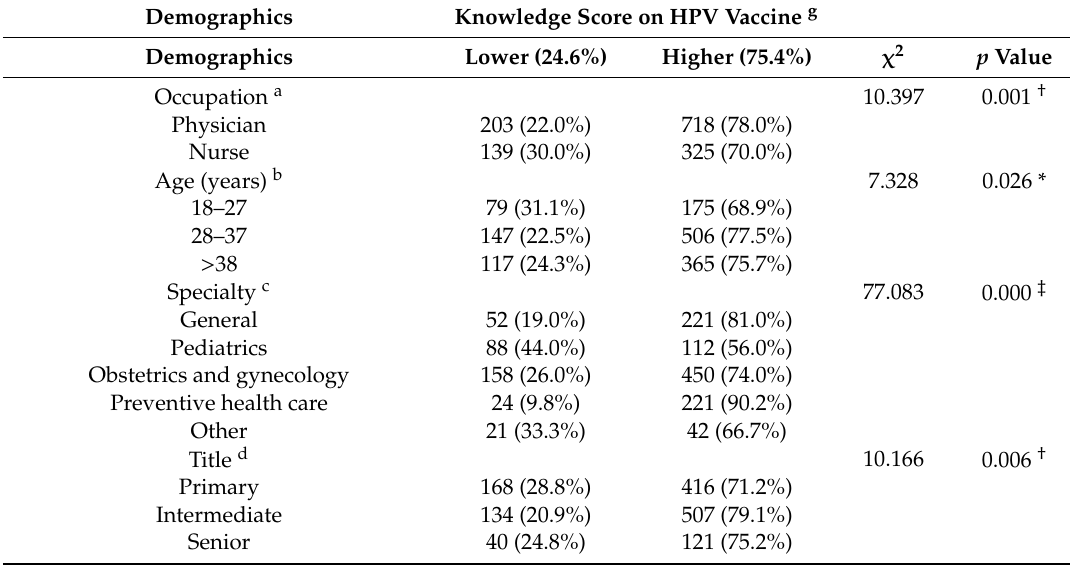
Table 3. Distribution of respondents between “lower” and “higher” knowledge scores based on the HPV vaccine knowledge